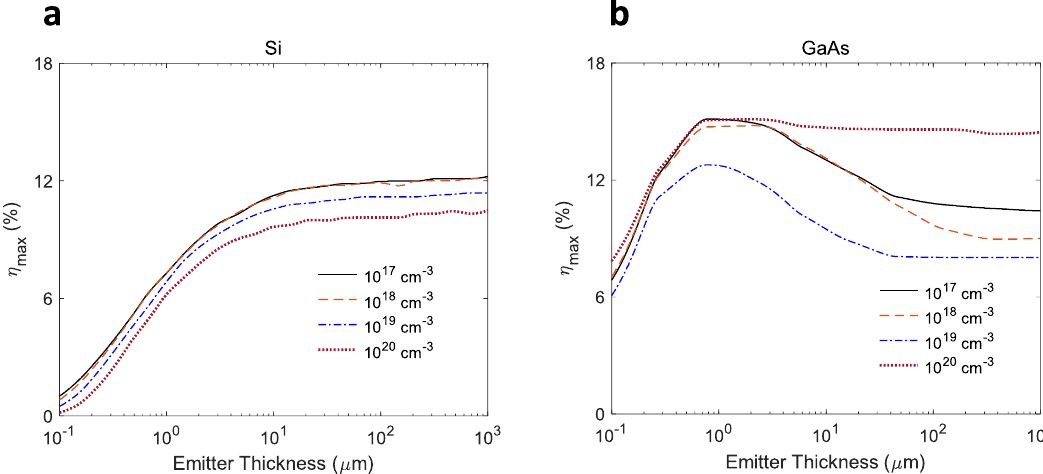
Fig. 2 Variation of the solar conversion ef fi ciency with emitter thickness. The data are shown at the maximum power point for a Si and b GaAs for different p-type doping levels in the emitter and a solar concentration ratio of